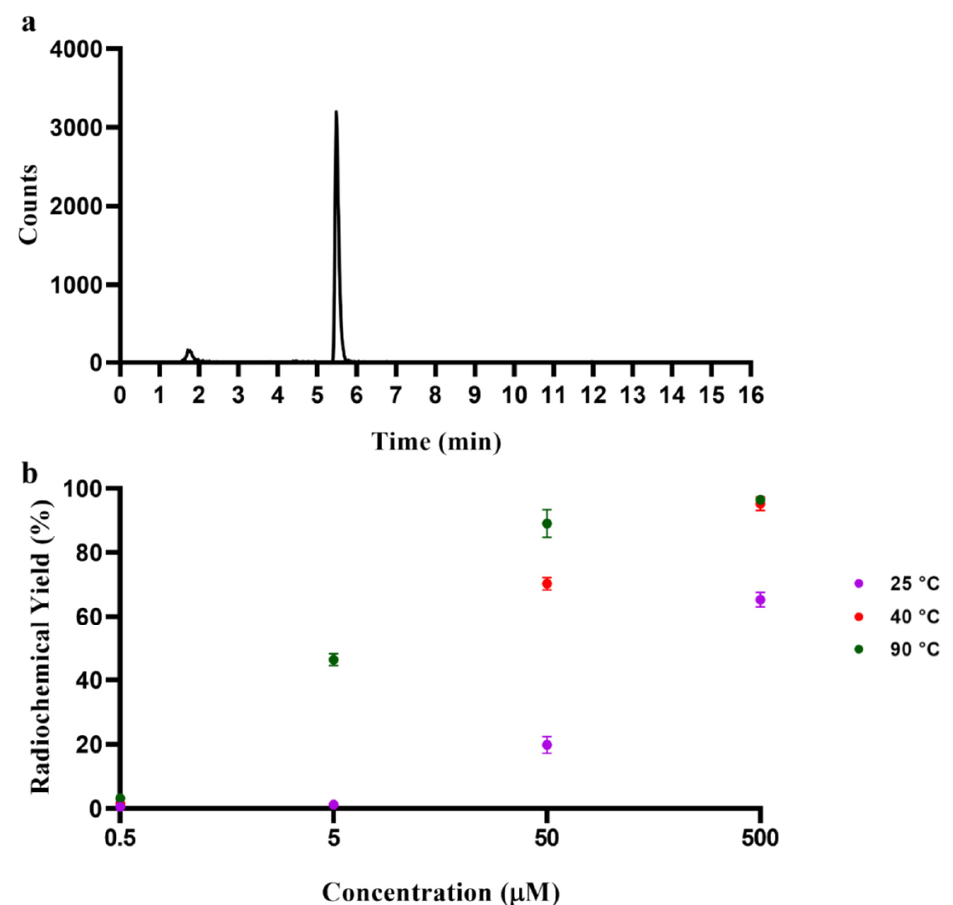
Figure 5. ( a ) Radio-HPLC chromatogram of the reaction between 68 Ga 3+ (1.2 MBq) and H 2 L (50 µ M) after 10 min at pH 6 and 90 ◦ C. ( b ) Radiochemical yields for the reaction of 68 Ga 3+ at various concentrations (0.5 to 500 µ M) and temperatures (25, 40 and 90 ◦ C) at pH 6 after 10